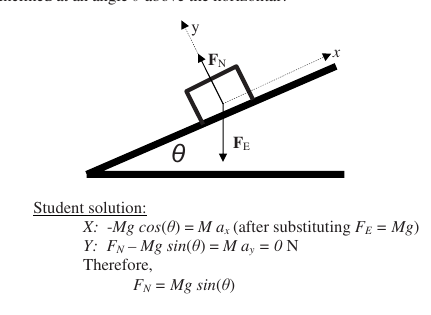
FIG. 1. An illustrative example of a traditional homework prob- lem and a possible